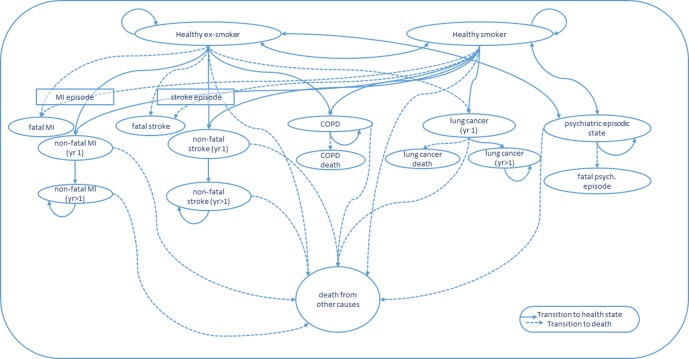
State transitions for Markov Model. COPD, chronic obstructive pulmonary disease; MI, myocardial infarction; yr 1, first year in a given health state; yr > 1, subsequent years lived in a given health state.